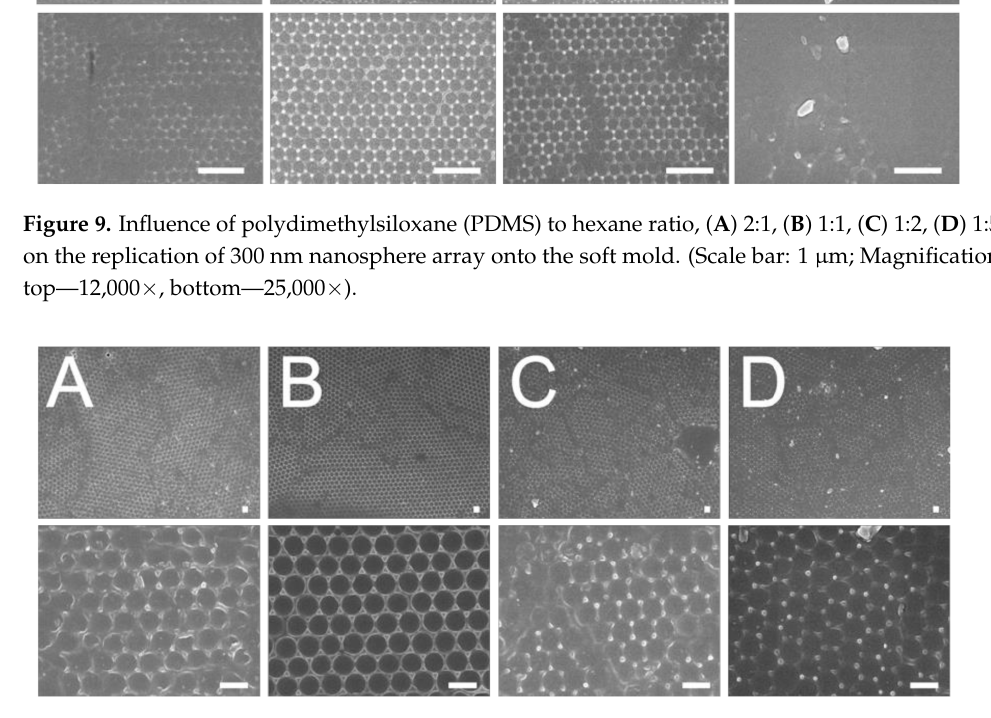
Figure 10. Influence of PDMS to hexane ratio, ( A ) 2:1, ( B ) 1:1, ( C ) 1:2, ( D ) 1:5, on the replication of 900 nm nanosphere array onto the soft mold. (Scale bar: 1 µ m; Magnification: top—3000 × , bottom—15,000 ×